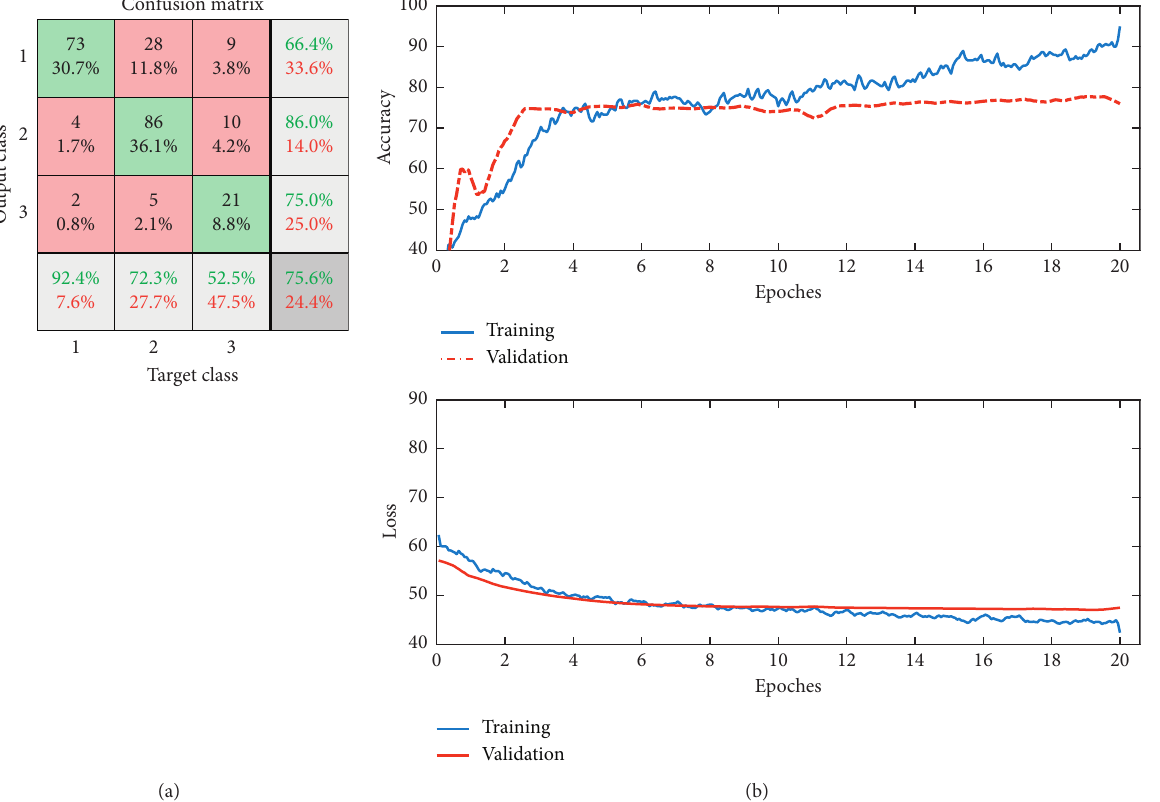
Figure 11: (a) Confusion matrix and (b) accuracy and loss curves for combination of STFT and